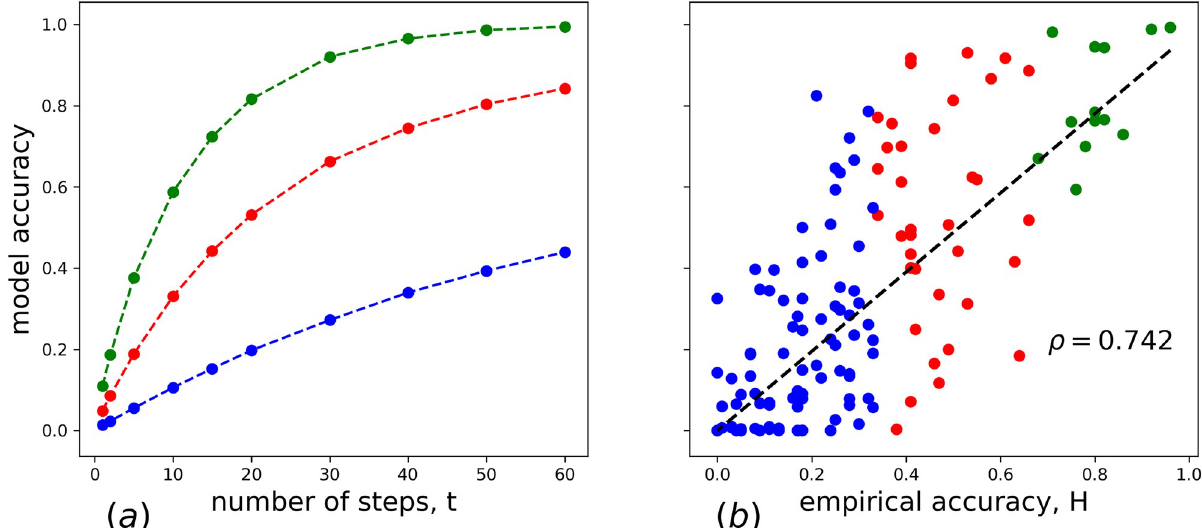
Fig 3. (a) The dependence of model accuracy on the number of search attempts (steps on SWOW-EN); (b) the scatter plot of model accuracy versus empirical accuracy of the RAT. The model accuracy is averaged over 10 4 simulations. The dashed line in (b) is the best linear fit to the data, ρ is the corresponding Pearson correlation